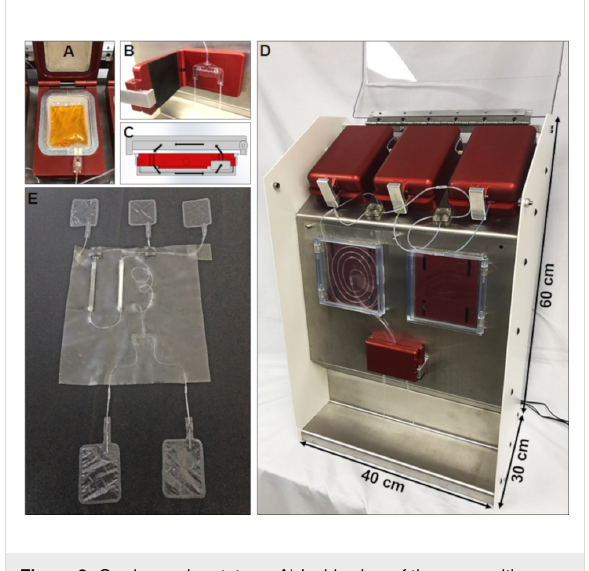
Figure 3: On-demand prototype. A) Inside view of the pump with a flexible bag containing a yellow liquid laying on an elastomer mem- brane. B) Detail of the manifold used to select the waste or product collection. C) Heater cross section, the arrows indicate the air convec- tion flow path. D) Reagents on-demand system assembled, with the coil reactor placed in the left reactor area. E) Example of a disposable